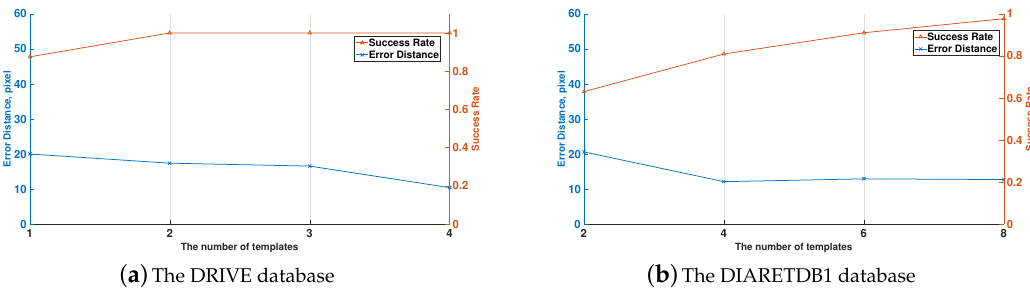
Figure 6. Error distances and success rates of OD detection using different numbers of